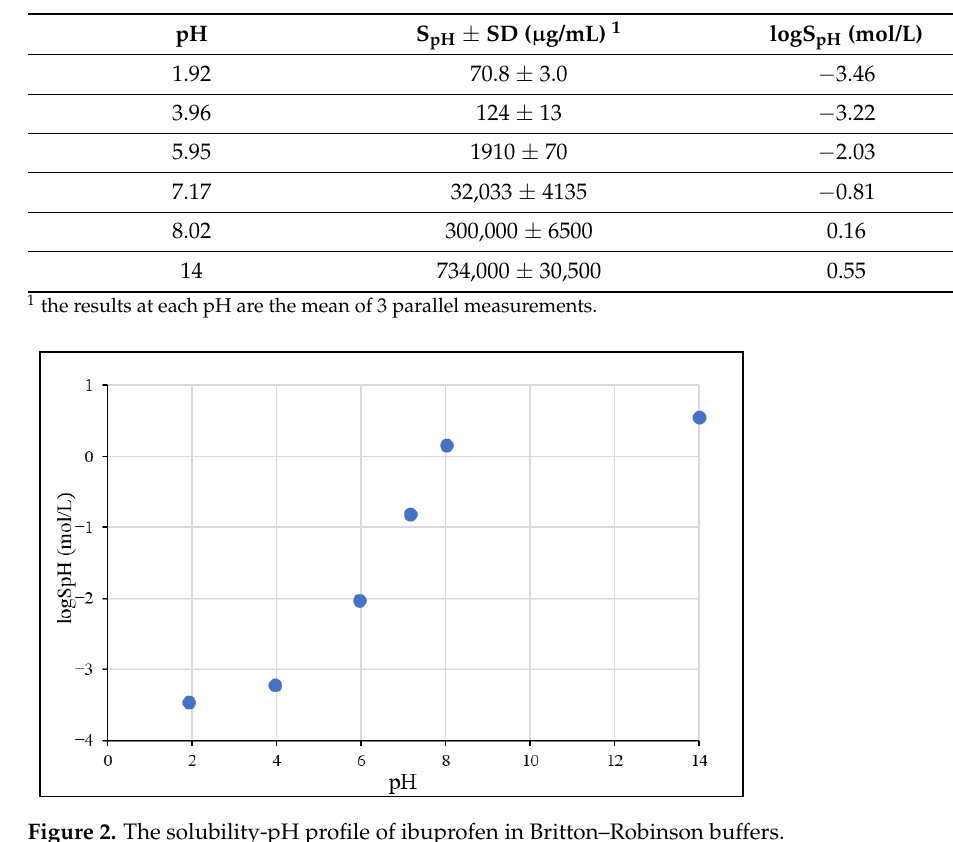
Figure 2. The solubility-pH profile of ibuprofen in Britton – Robinson buffers.